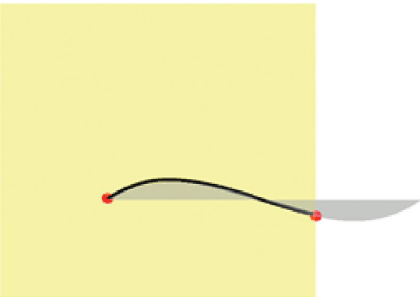
Figure 21: xy -view of intersection along with boundary and turning points.